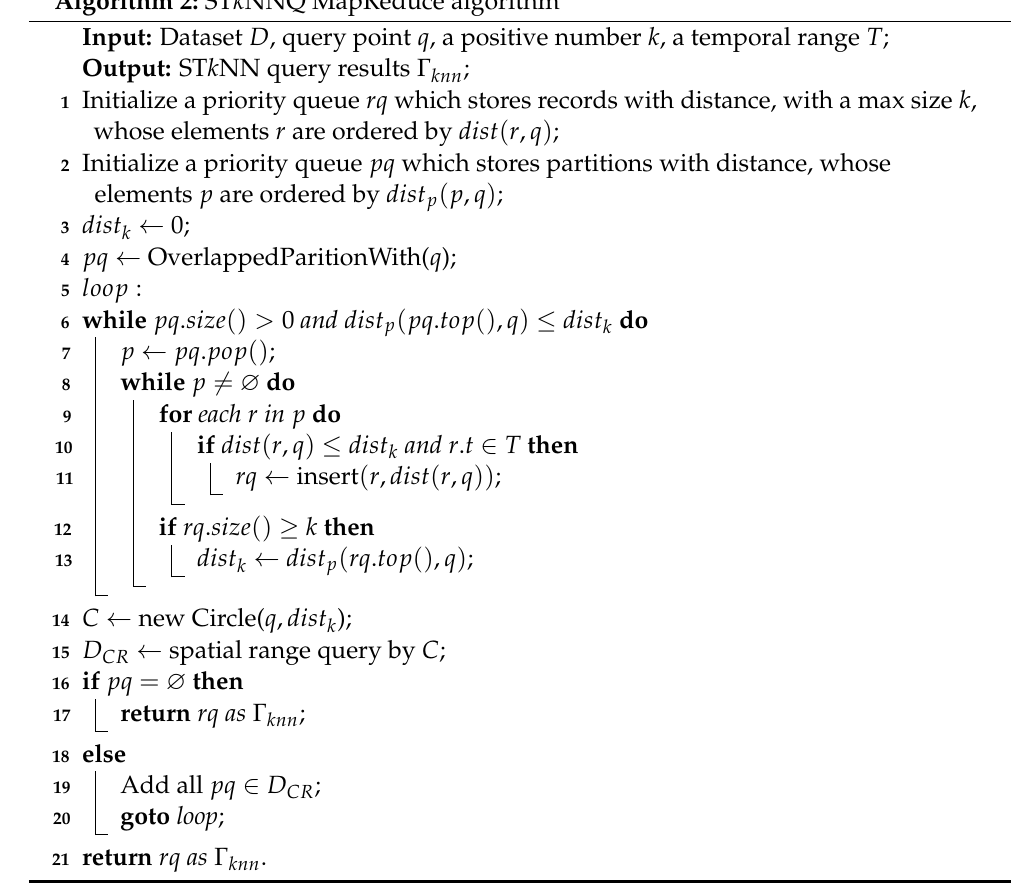
Algorithm 2: ST k NNQ MapReduce